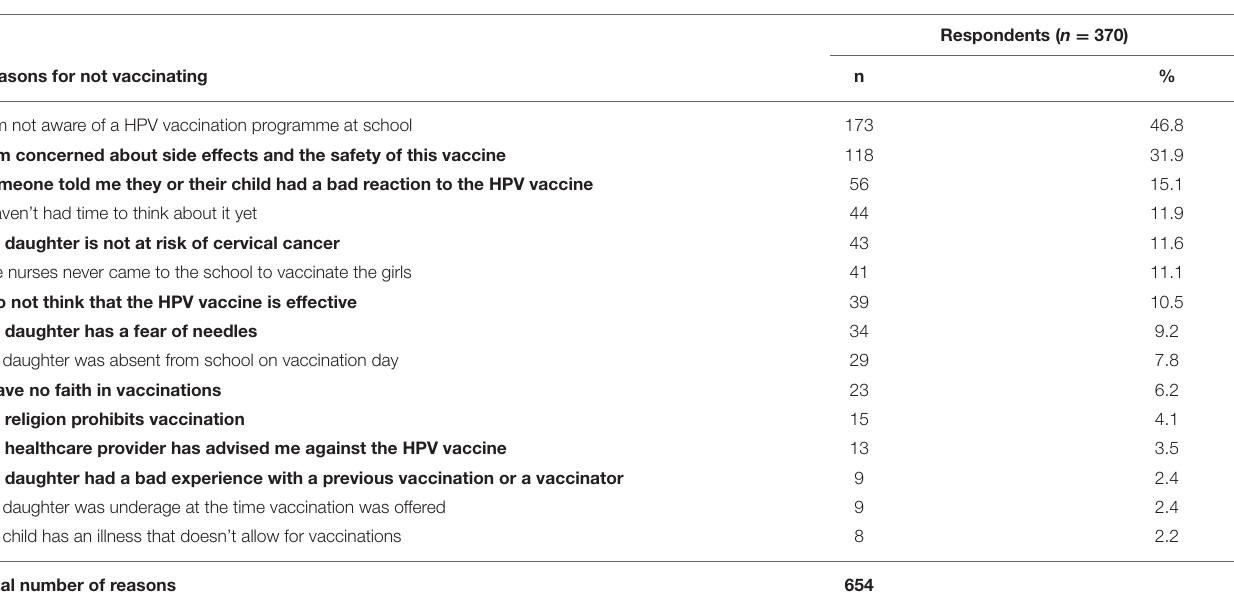
TABLE 3 | Frequency distribution of reasons for